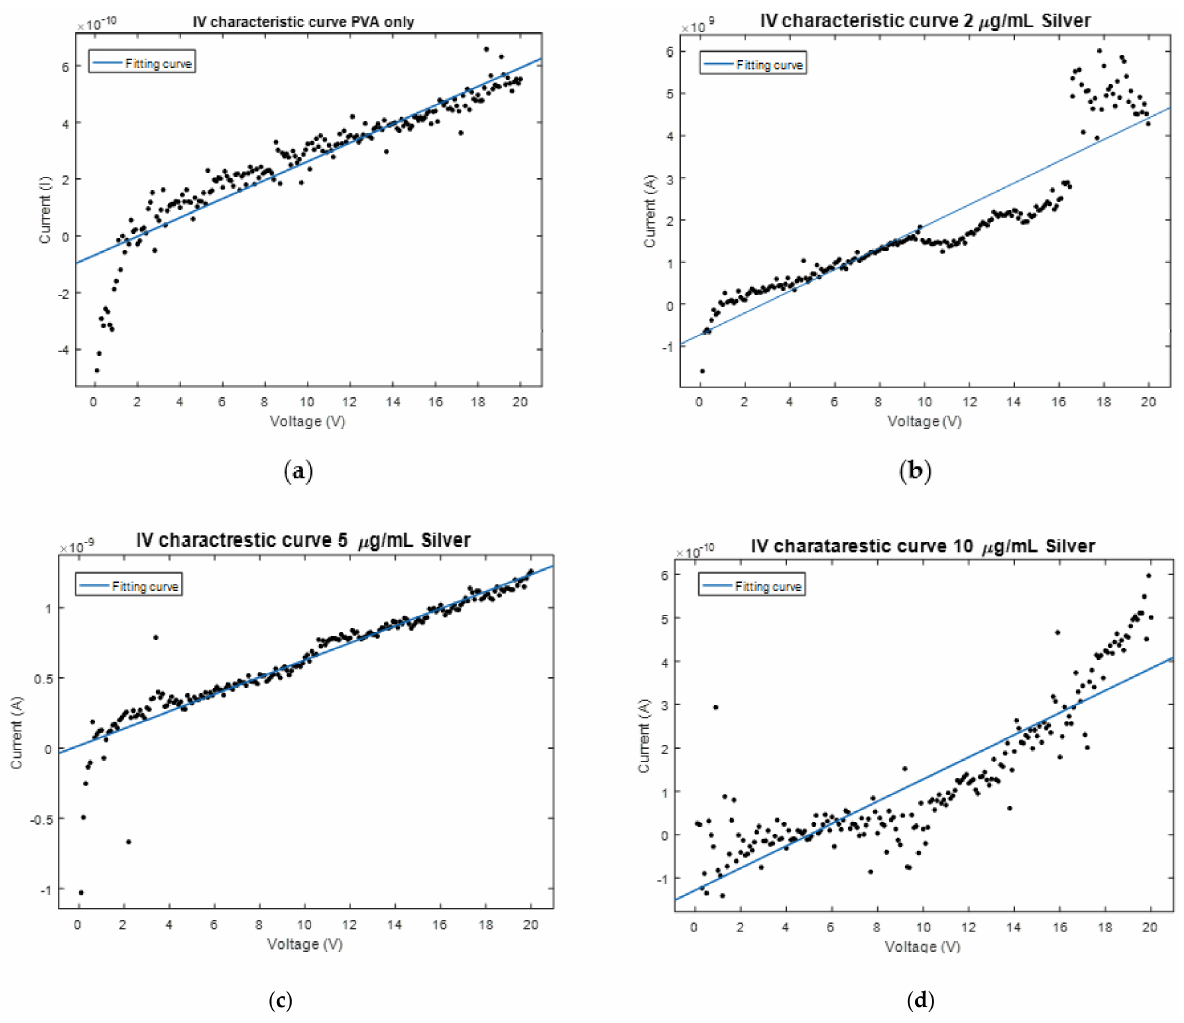
Figure 3. I-V characteristics of Ag NPs-embedded-PVA electrospun nanocomposites at different weight concentration ( a ) 0 µ g/mL, ( b ) 2 µ g/mL, ( c ) 5 µ g/mL, ( d ) 10 µ